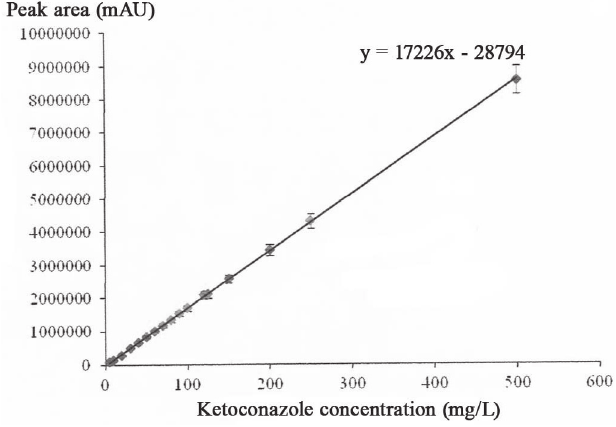
FIGURE 2 - Calibration curve of ketoconazole standard in the concentration range 1-500 mg L -1